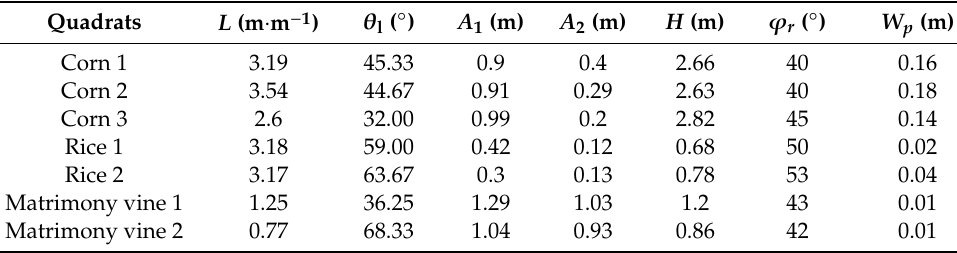
Table 3. Structural parameters of crops in the